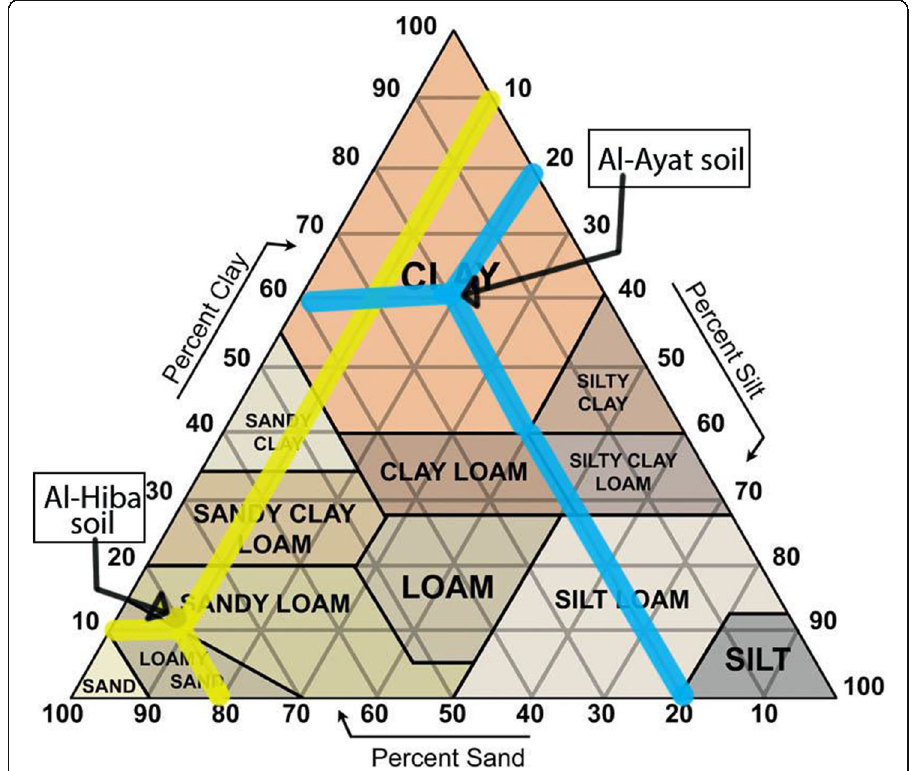
Fig. 2 The soil texture triangle showing Al-Hiba and Al-Ayat soils (modified by authors)